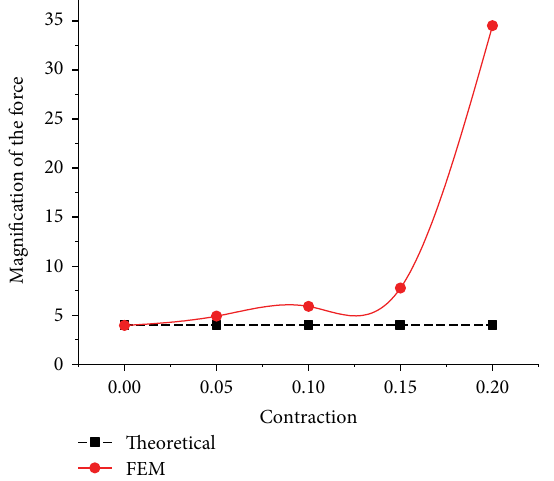
Figure 11: Magnification of force of PAM with a diameter of 40 mm to that of PAM with a diameter of 20 mm.